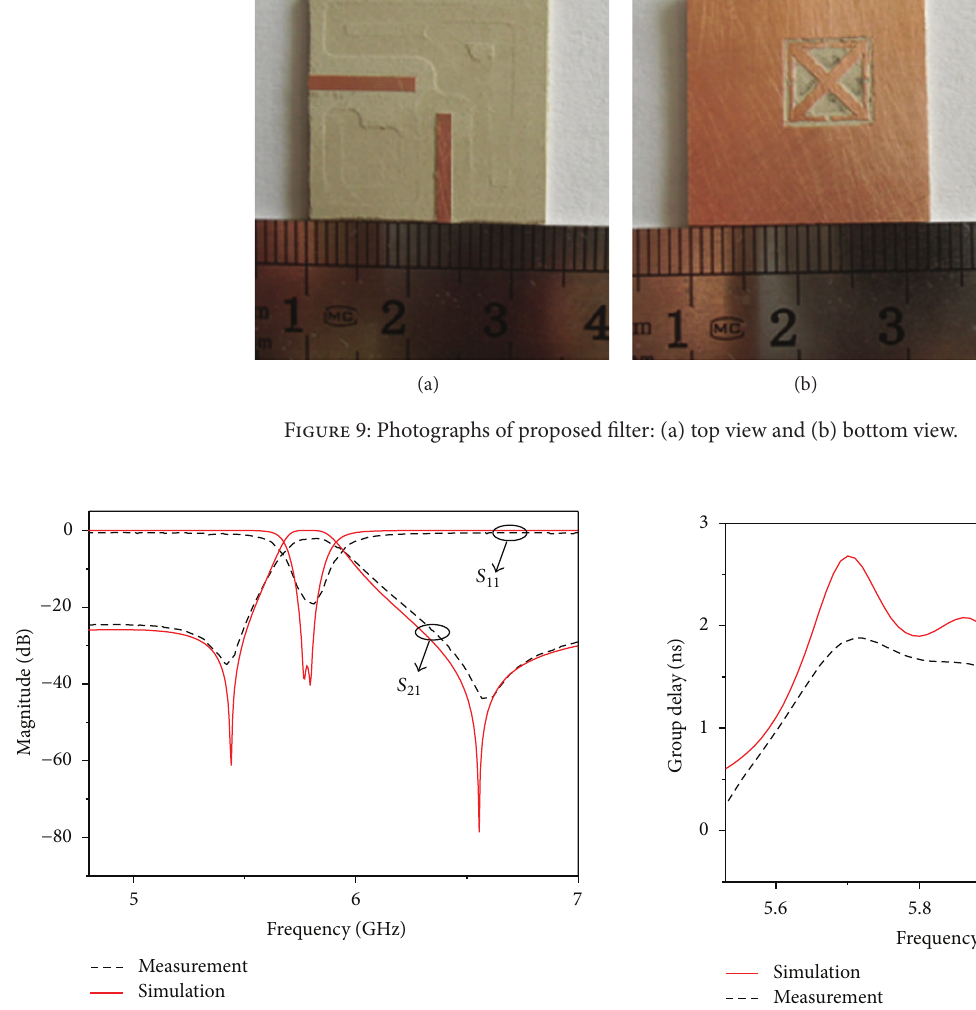
Figure 11: Group delay of the proposed miniaturized